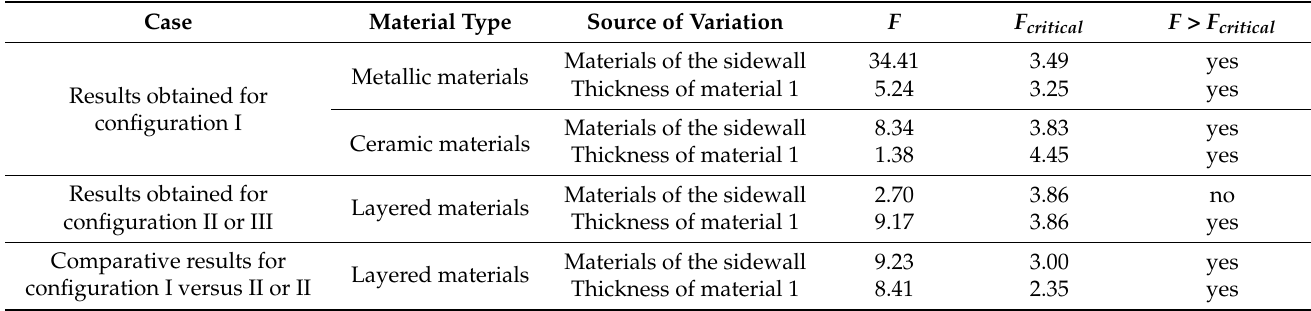
Table 8. Two-way ANOVA applied to the sidewall heat loss